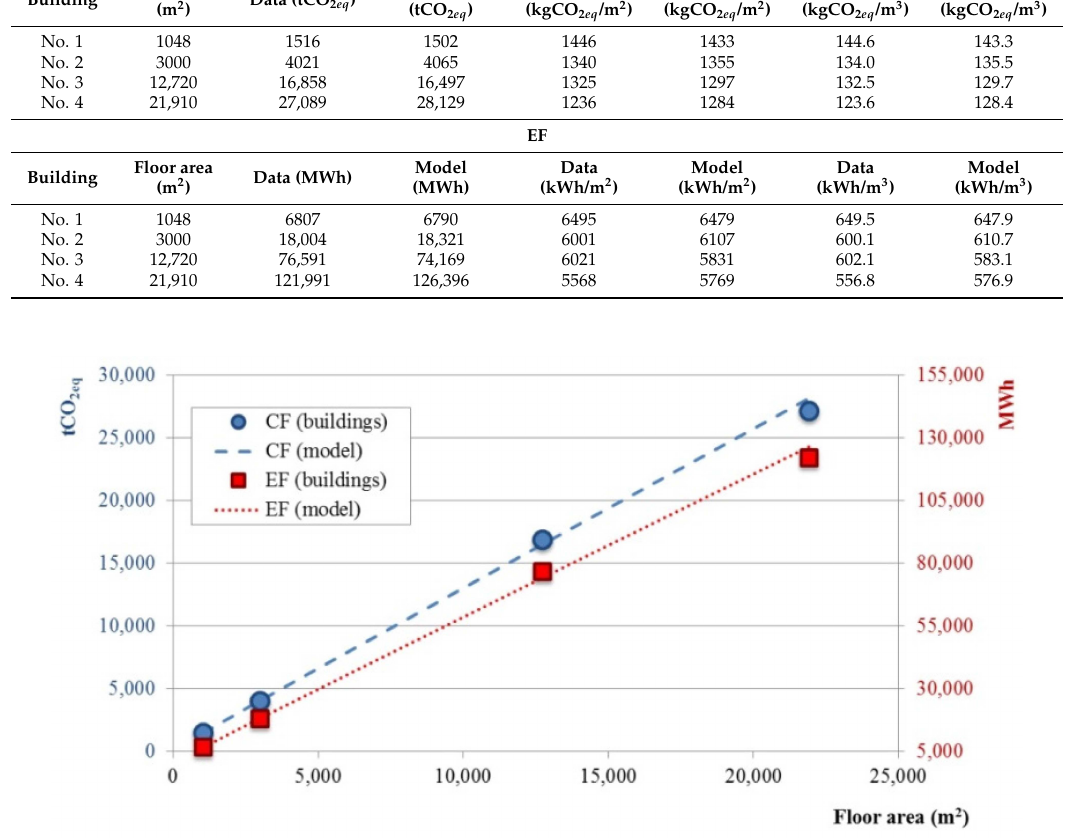
Figure 4. Carbon ( blue ) and Energy ( red ) footprint comparison of the four selected buildings ( points ) vs . the model ( lines ) for the reference scenario.